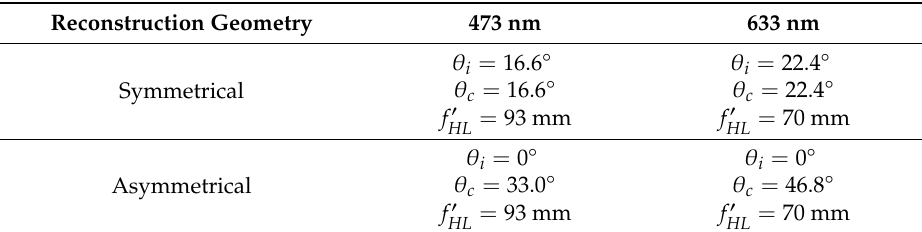
Figure 4. Experimental setup for the evaluation of the aberrated wavefront of holographic lenses. F: filter, SF: spatial filter, L: lens, D: diaphragm, HL: holographic lens, HS Sensor: Hartmann–Shack wavefront sensor. Table 2. Parameters for the evaluation of the